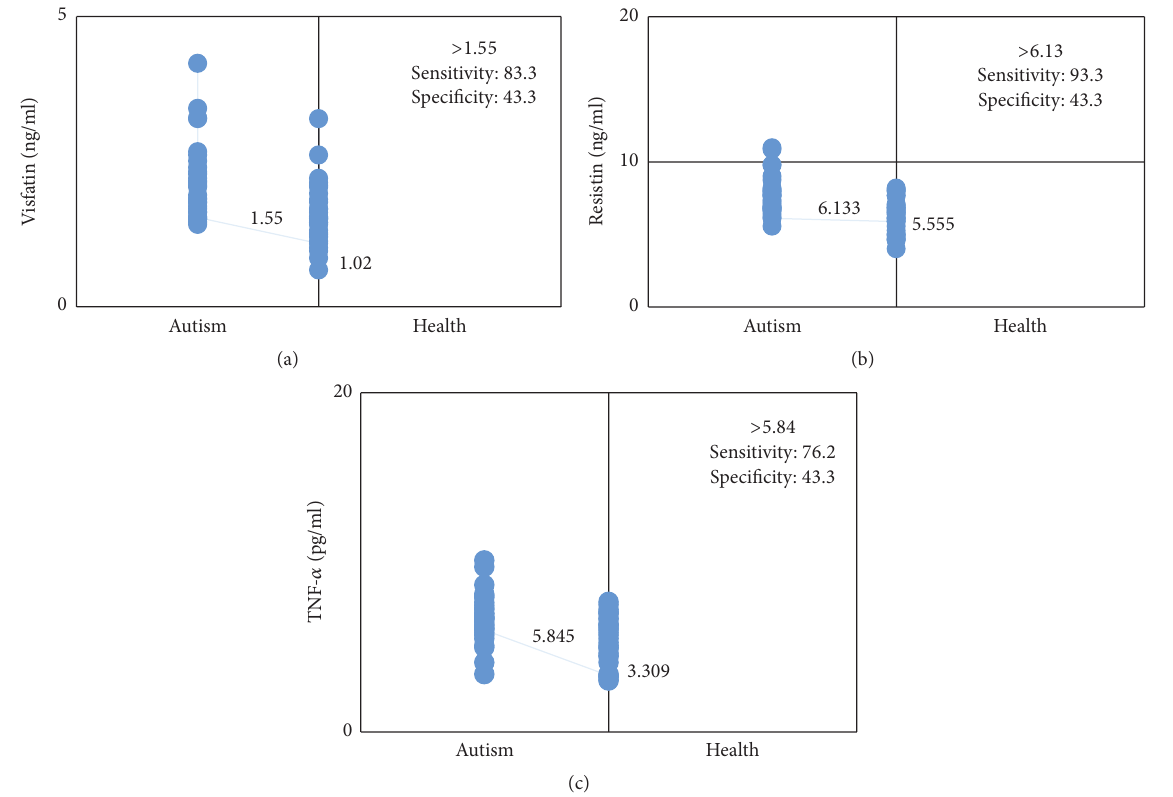
Figure 1: Interactive dot diagram comparing levels of visfatin (a), resistin (b), and TNF- 𝛼 (c) in autistic and healthy children.